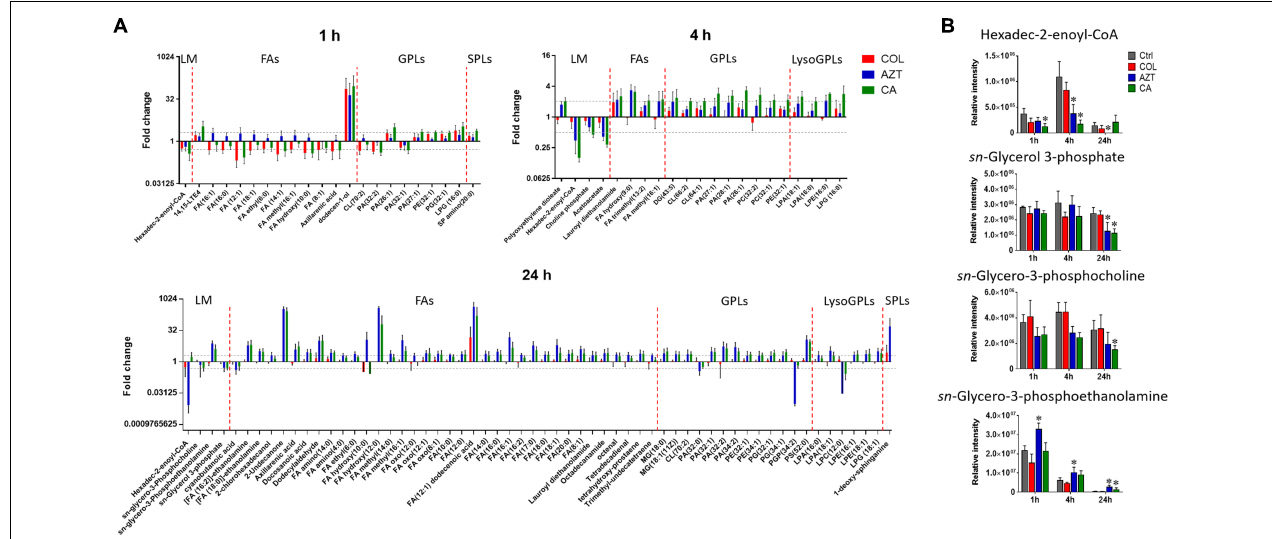
FIGURE 6 | Perturbations of lipids and the related metabolites in A. baumannii AB090342. (A) Significantly perturbed major lipid classes following the treatment with colistin (COL, red), aztreonam (AZT, blue), and the combination (CA, green) at 1, 4, and 24 h. Lipid names were putatively identified based on the accurate mass. LM: lipid metabolism; FAs: fatty acids; GPLs: glycerophospholipids; SPLs: sphingolipids. (B) Significantly perturbed metabolites related to fatty acid and phospholipid synthesis and degradation after treated by colistin, aztreonam and the combination across all three time points. ∗ FDR < 0.05, p < 0.05 and log 2 FC ≥ 1 or ≤ –1 (one-way